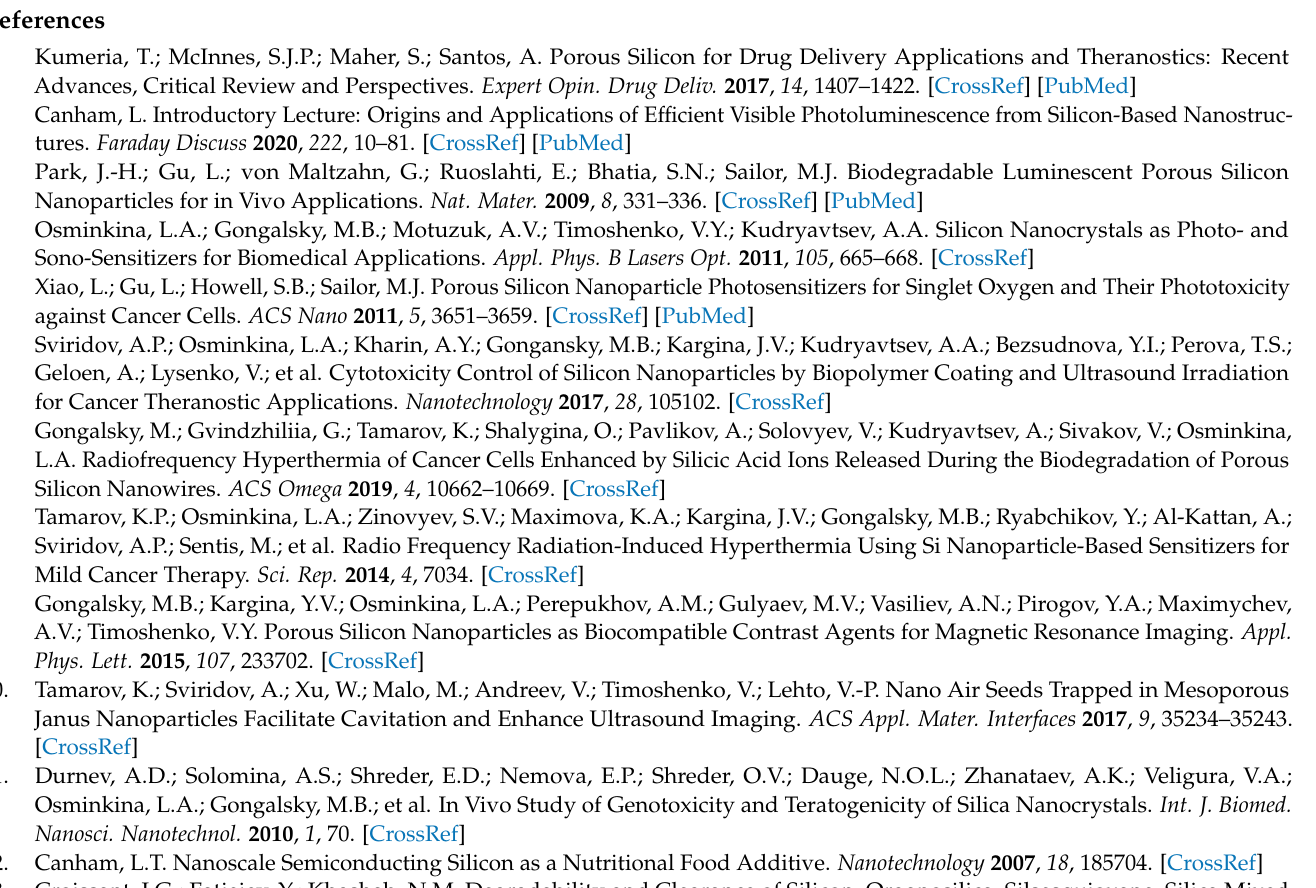
data, Figure S3: Dark field images of SiNPs, Figure S4: PL spectrum deconvolution, Figure S5: Cytotoxicity for MCF-7 cells, Figure S6: Raman bioimaging of SiNPs in HEK293T cells, Figure S7: Raman spectrum deconvolution, Figure S8: Luminescent bioimaging of SiNPs in MCF-7